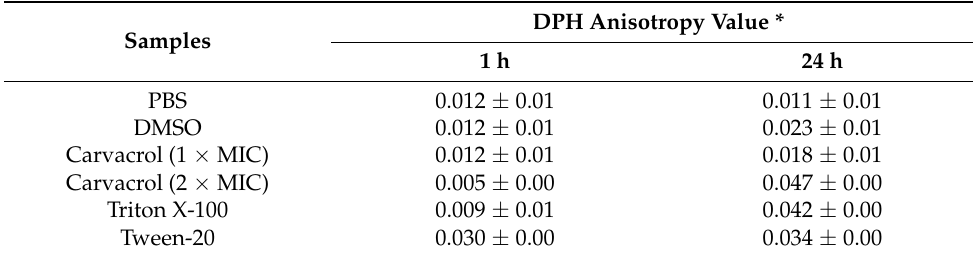
Table 1. Changes in membrane fluidity in the presence of carvacrol on Streptococcus pyogenes spy 1558 live cells.